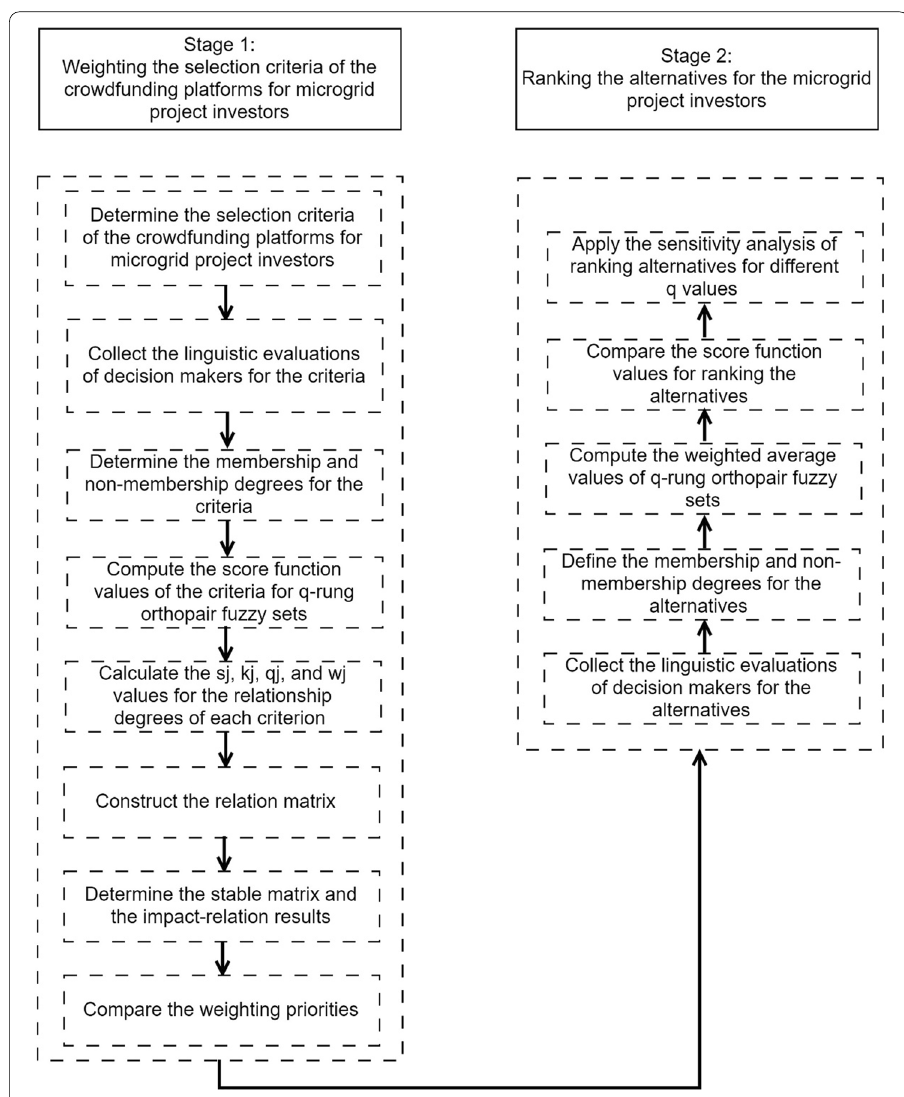
Fig. 1 Algorithm of the proposed decision-making